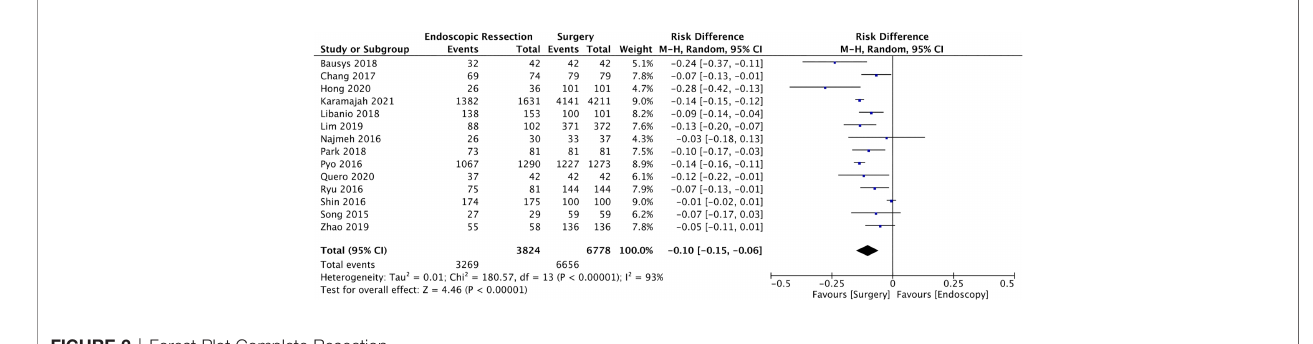
FIGURE 2 | Forest Plot Complete Resection.